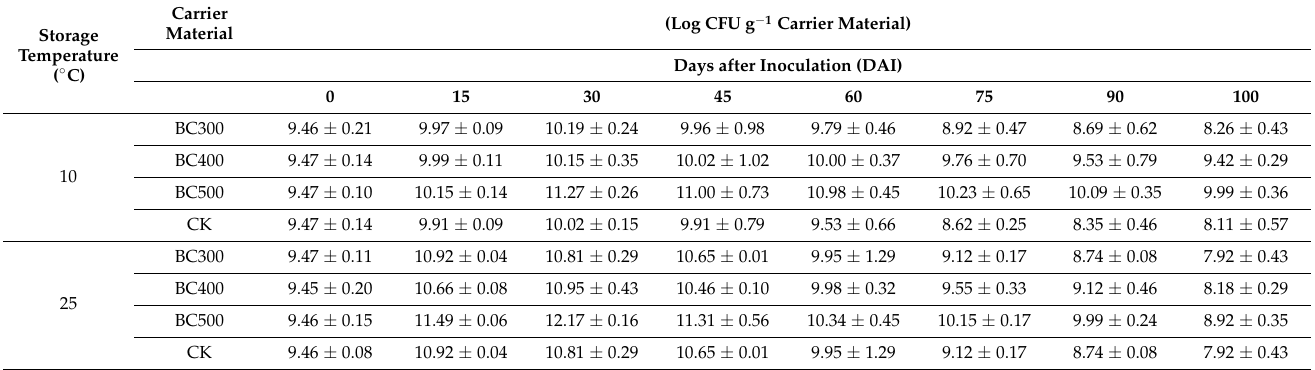
Table 2. Shelf-life of Tpb55 on biochar under various storage temperatures (initial concentration of 10 9 CFU g − 1